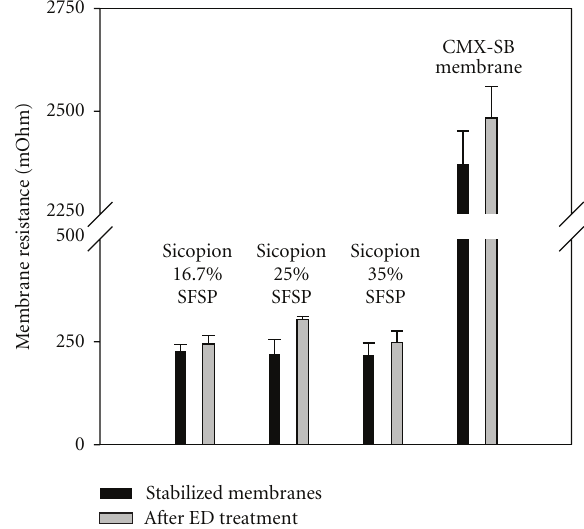
Figure 3: Thickness of conditioned and used (24h after the ED procedure) Sicopion and CMX-SB membranes.